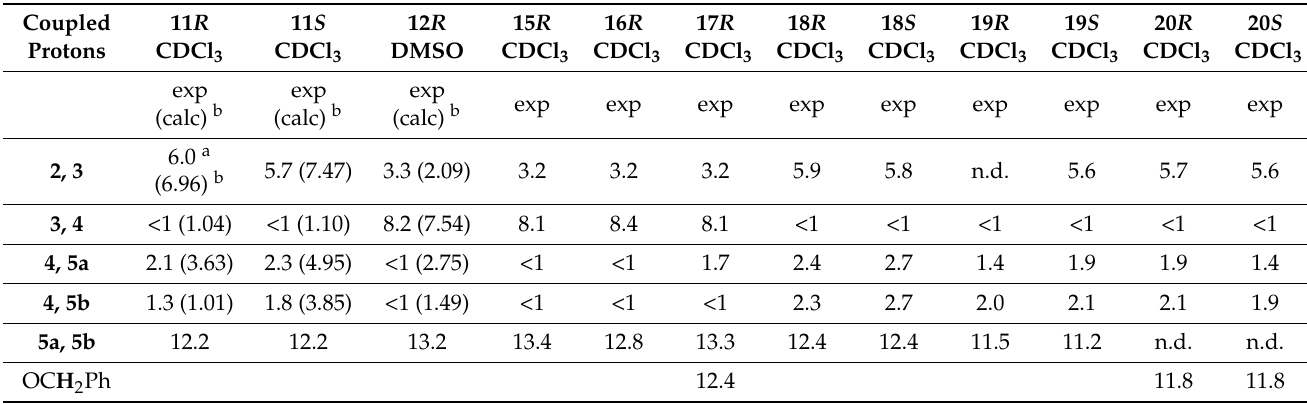
Table 3. 1 H NMR coupling constants (Hz) a of R and S epimers of 11 , 18 – 20 and R epimers of 12 , 15 –